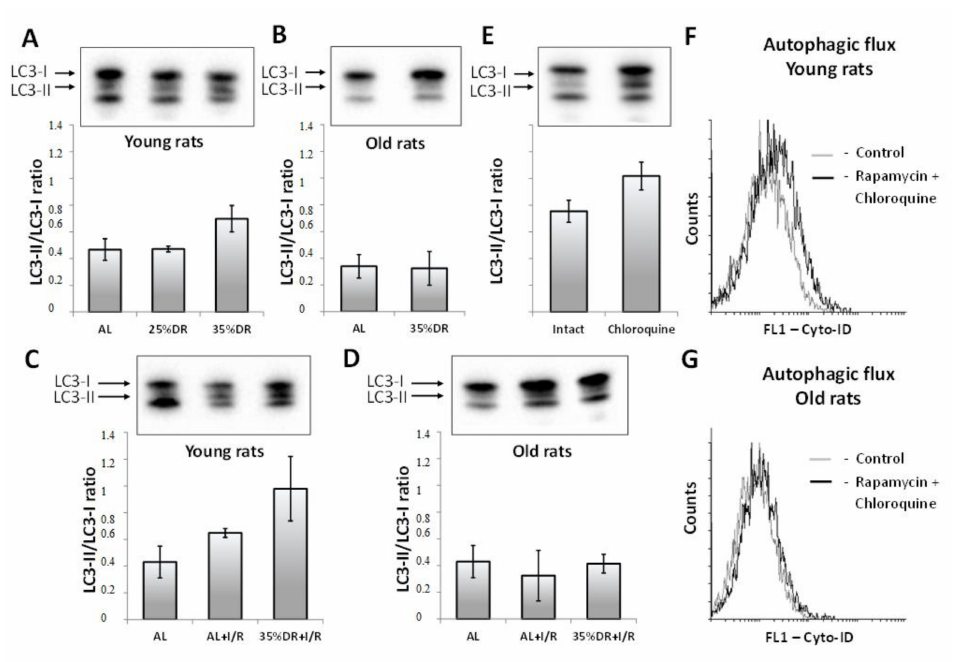
Figure 2. The assessment of autophagic activity in young and old rats. ( A , B ) LC3 II/LC3 I ratio in kidney homogenates of young and old control rats on AL or DR; ( C , D ) LC3 II/LC3 I ratio in kidney homogenates of young and old rats on AL or DR 48 hours after I/R; ( E ) LC3 II/LC3 I ratio in kidney homogenates of young rats after the injections of chloroquine (20 mg/kg/day) for 3 days; ( F , G ) Autophagic flux in primary cultures of renal tubular cells (RTCs) obtained from the kidneys of young and old rats, after incubation with rapamycin and